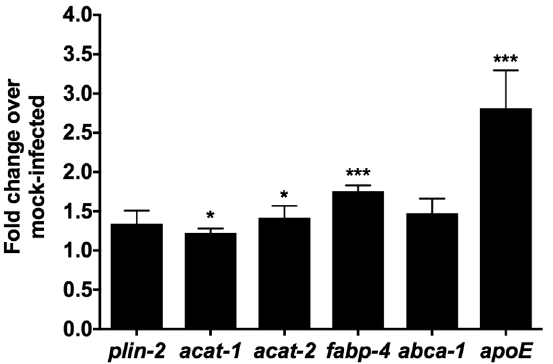
Fig 1. LD-associated genes are upregulated in C . burnetii- infected alveolar macrophages. MH-S macrophages were infected with wild-type C . burnetii and RNA was collected at day 1 post-infection. Gene expression analysis was performed using Applied Biosystems lipid-regulated TaqMan Array. Fold change was calculated compared to mock- infected samples. Error bars show the mean of 6 independent experiments +/- SEM (cid:3) = p < 0.05, (cid:3)(cid:3)(cid:3) = p < 0.001 compared to respective mock-infected cells as determined by two-tailed paired